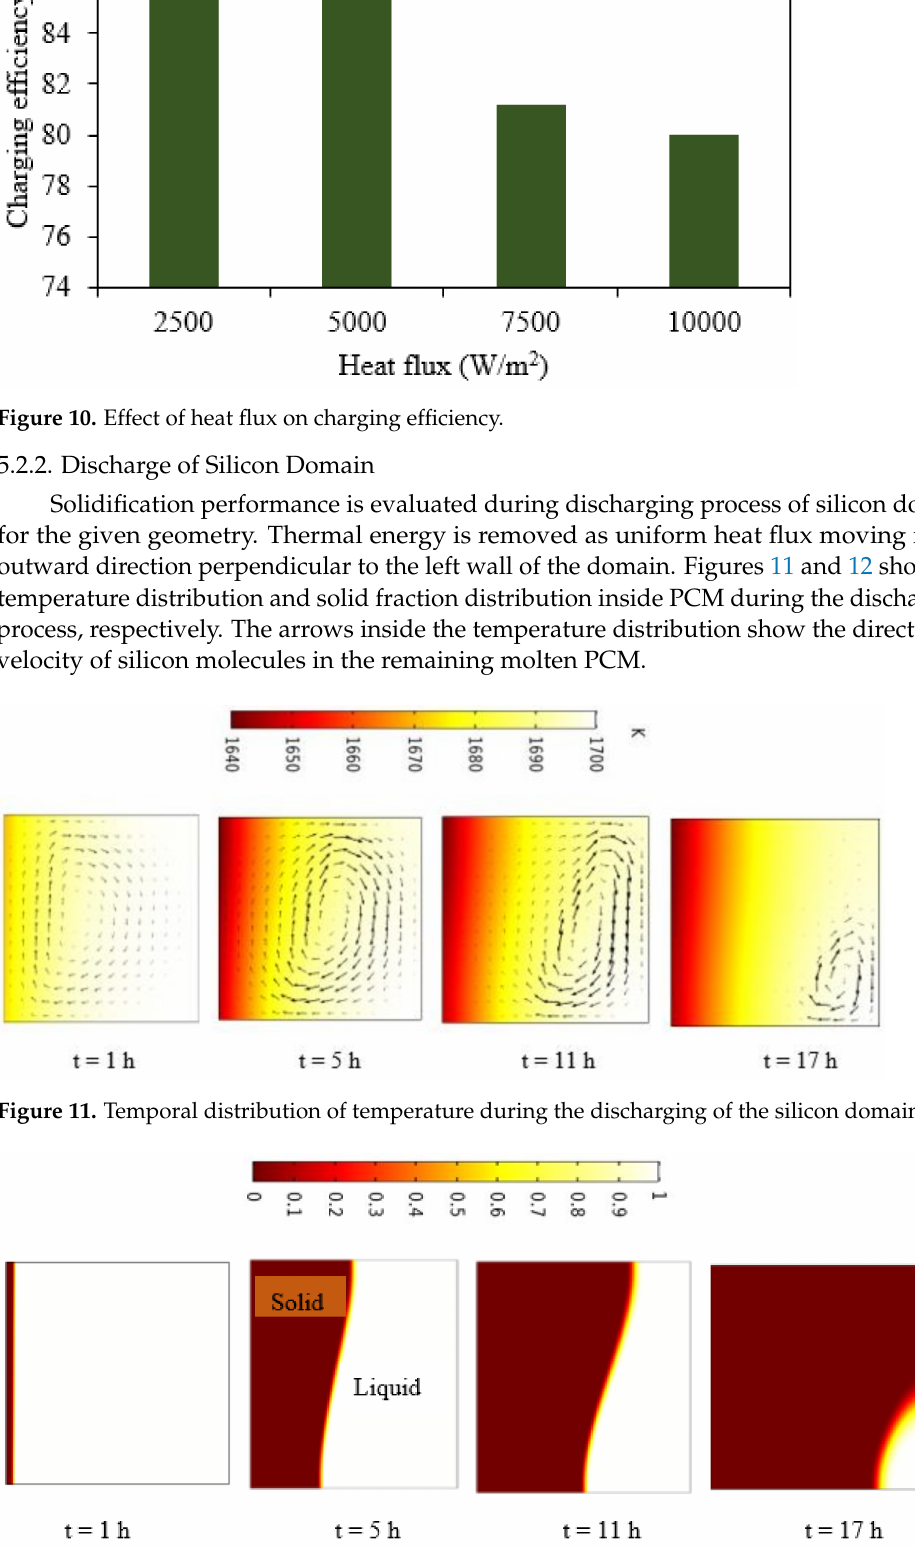
Figure 12. Temporal distribution of solid fraction during the discharging of the silicon